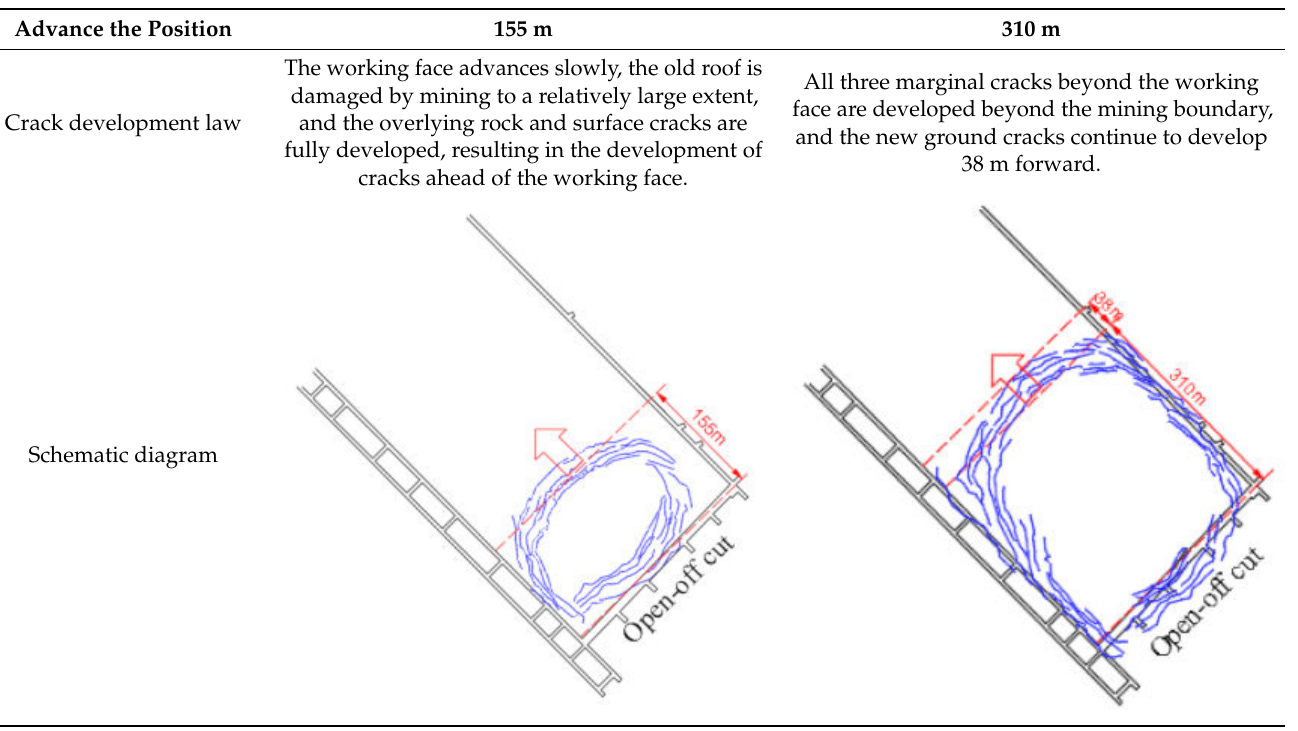
Table 6. Variation of the development regularity of surface cracks with the advanced distance of working face.